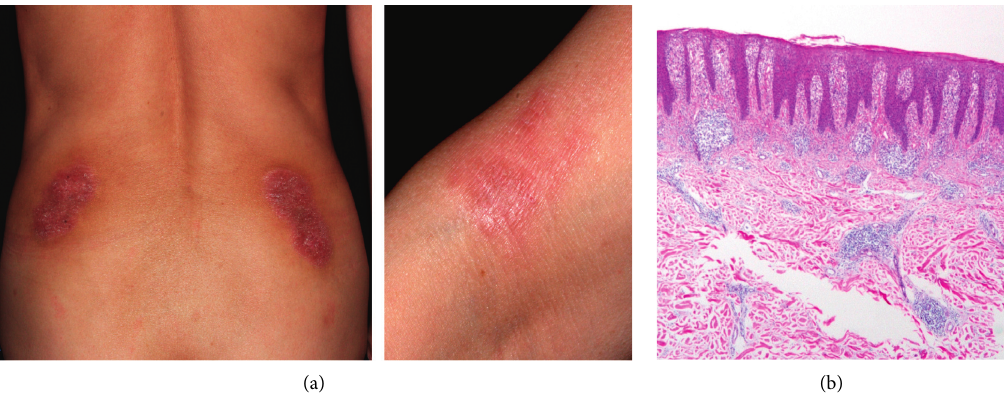
Figure 2: Skin lesion in patient 2. (a) Gross inspection reveals psoriasis-like skin lesions on the back and right elbow. (b) Histological findings show marked elongated rete ridges, mild parakeratosis, and pronounced lymphoid cell infiltration in the upper dermis (H&E stain ×